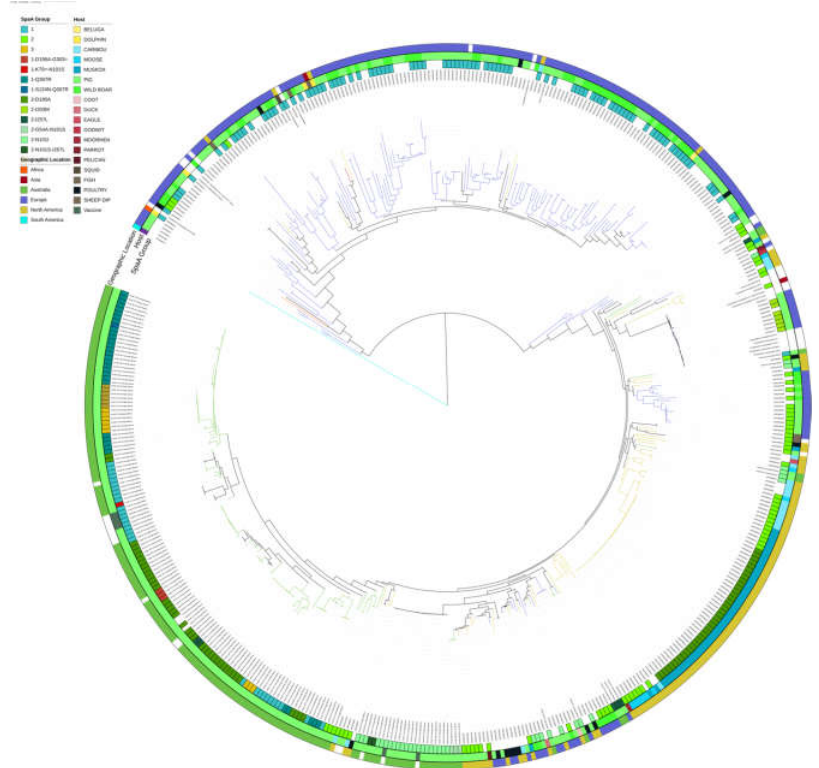
Figure 2. Core gene phylogenetic tree inferred with core_gene_phylo from 511 genes. Annotated rings, moving inside to out, show: SpaA protein group identified in the isolate, presence of surface proteins, host the sample was isolated from, and geographic location of isolation. Branches are also coloured to reflect the geographic location.